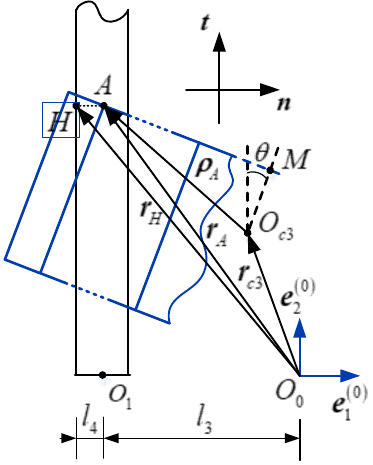
Figure 8. A simplified model for solving the embedding depth. Analyzing the simplified model, it is clear that the potential contact points on the two elements must be at the endpoints of the edges of the guide holes.